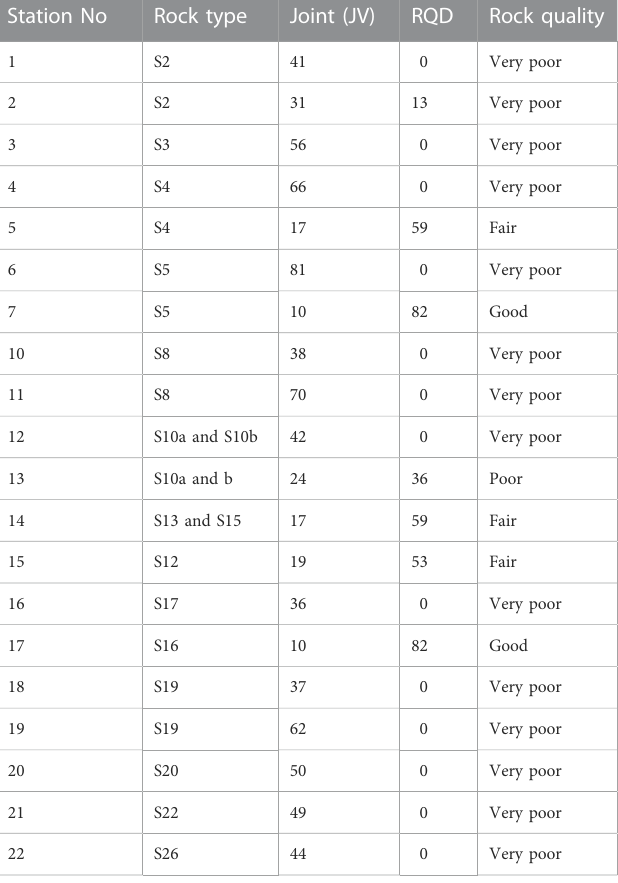
TABLE 8 Correlation of RQD and joint volume, which shows the rock quality. Station